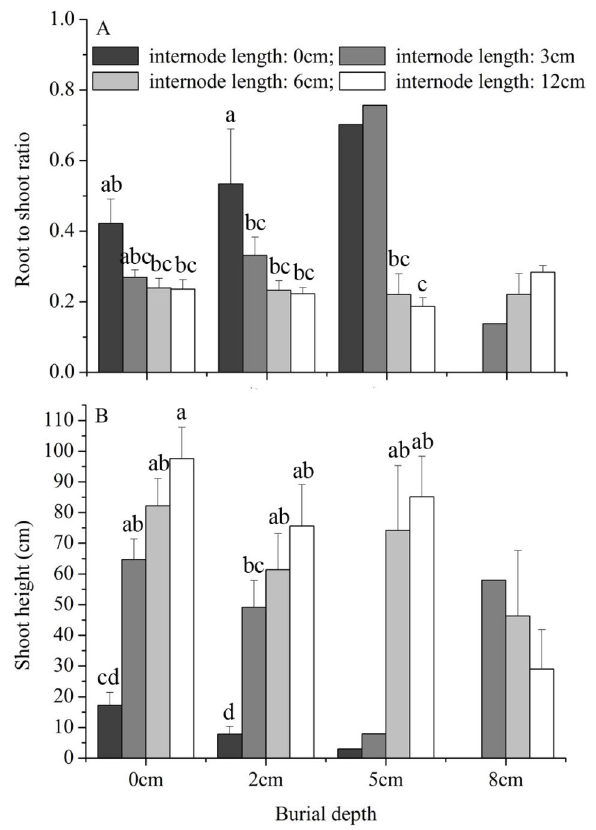
Figure 3. Effects of burial depth and stolon internode length on morphology of Mikania micrantha . Root to shoot ratio and shoot height are given. Error bars represent the mean ± SE. One-way ANOVAs with post-hoc Duncan’s tests were used for the multiple comparison analyses (data on root to shoot ratio were first multiplied by 10 and then ln-transformed prior to analyses), and significant differences (at the significance level of P =0.05) between two treatments are marked with the use of different symbols.